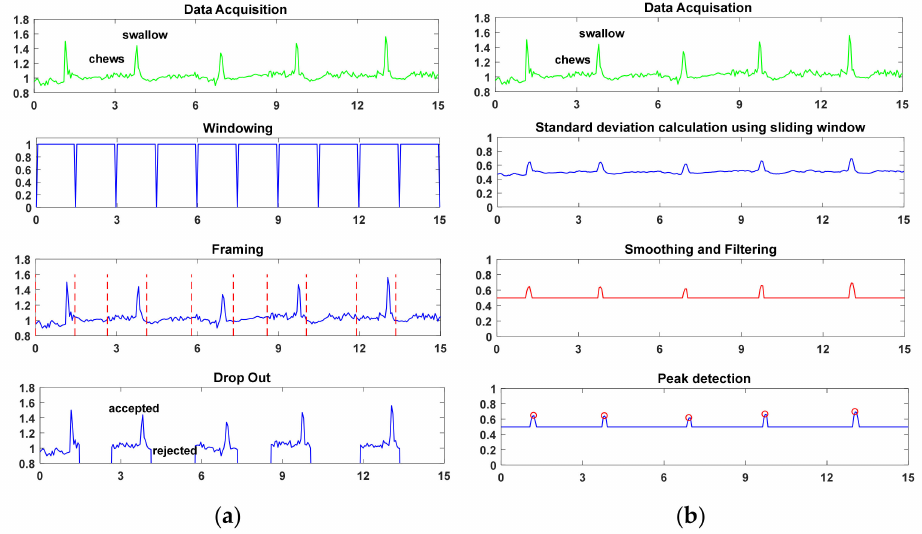
Figure 6. Comparison of data processing techniques: ( a ) Proposed data processing technique; ( b ) Previous work data processing technique [4,7].